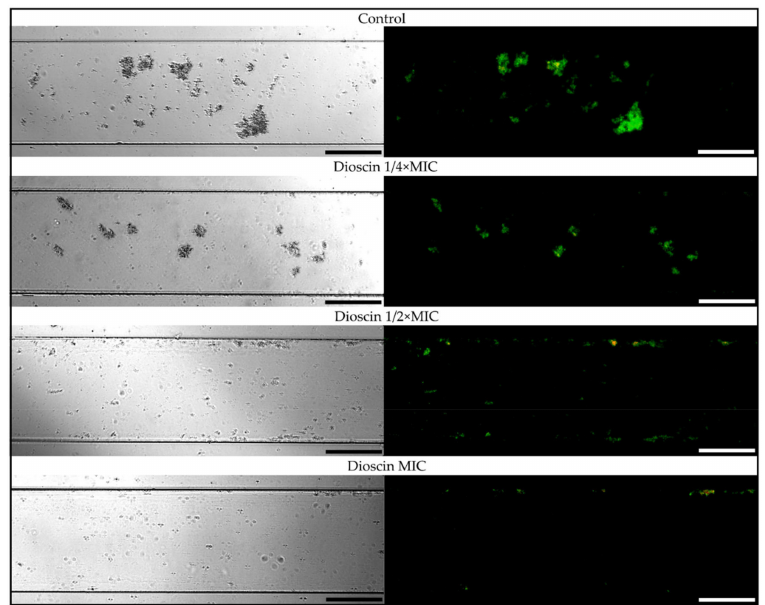
Figure 4. Representative photos obtained after 24 h of experiments determining anti-biofilm activity of dioscin under flow conditions against H. pylori J99. The flow conditions were generated using × MIC, and 1 × MIC had values of 64 µ g/mL, 32 µ g/mL, and the Bioflux 1000 system. The MIC, 1 2 4 16 µ g/mL, respectively. Control samples were bacteria not exposed to any concentration of dioscin. The pictures on the right show cells stained with the LIVE/DEAD kit (green and red fluorescence showing live and dead cells, respectively) and viewed under a fluorescence microscope, while the pictures on the left show cells under a light microscope. Scale bars show 10 µ m.